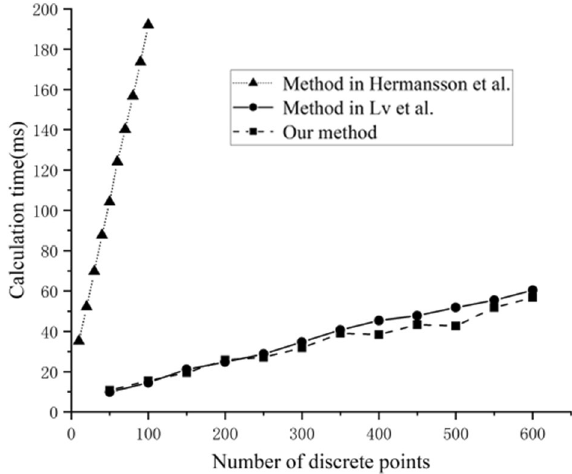
Figure 8. Solution times for numbers of different discrete points.